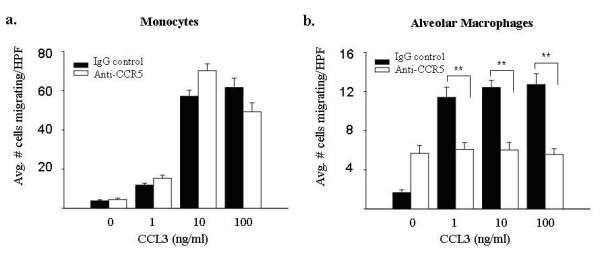
Blocking antibodies to CCR5 decrease CCL3-induced chemotaxis in alveolar macrophages, but not fresh monocytes. Freshly isolated monocytes and alveolar macrophages (4.5 × 104/condition) were pre-incubated with 1 μg/ml CCR5 blocking antibodies and subjected to a migration assay using CCL3 (1–100 ng/ml) as the chemoattractant. The addition of anti-CCR5 antibodies did not significantly alter monocyte chemotaxis (left panel) at any concentration of CCL3 compared to the IgG control (p > 0.05 at all concentrations). In contrast, the addition of anti-CCR5 antibodies decreased CCL3-induced alveolar macrophage chemotaxis (right panel) at all tested concentrations of CCL3 (**p < 0.001). Results represent mean ± SEM for three independent studies.